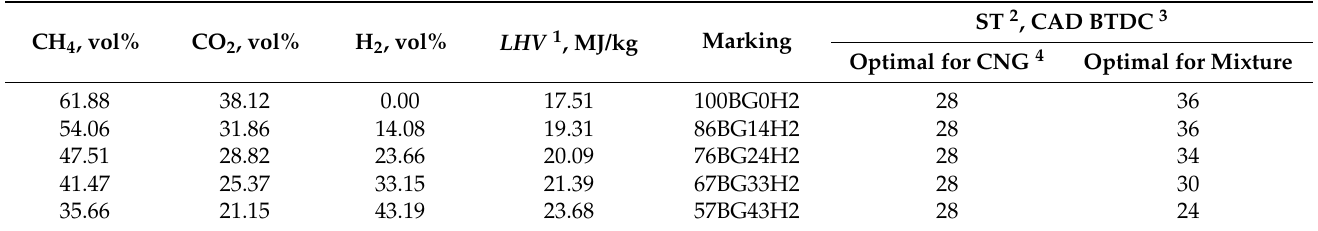
Table 3. Fuel composition, marking of mixtures and spark timing.